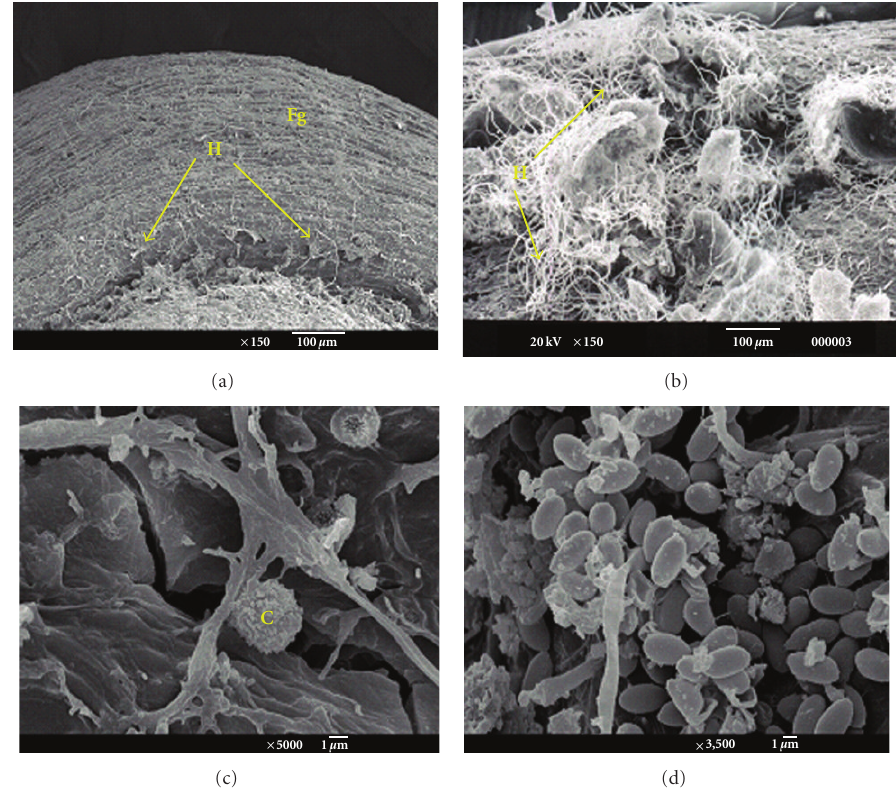
Figure 7: Micrographs of microorganisms on the funicular cover of Opuntia tomentosa seeds exhumed after 5 months of burial: (a) hyphae on the funicular envelope; (b) massive growth of mycelia on the funicular envelope; (c) hyphae and conidiophores, (d) spores. C: conidiophores, Fg: funicular girdle, H: